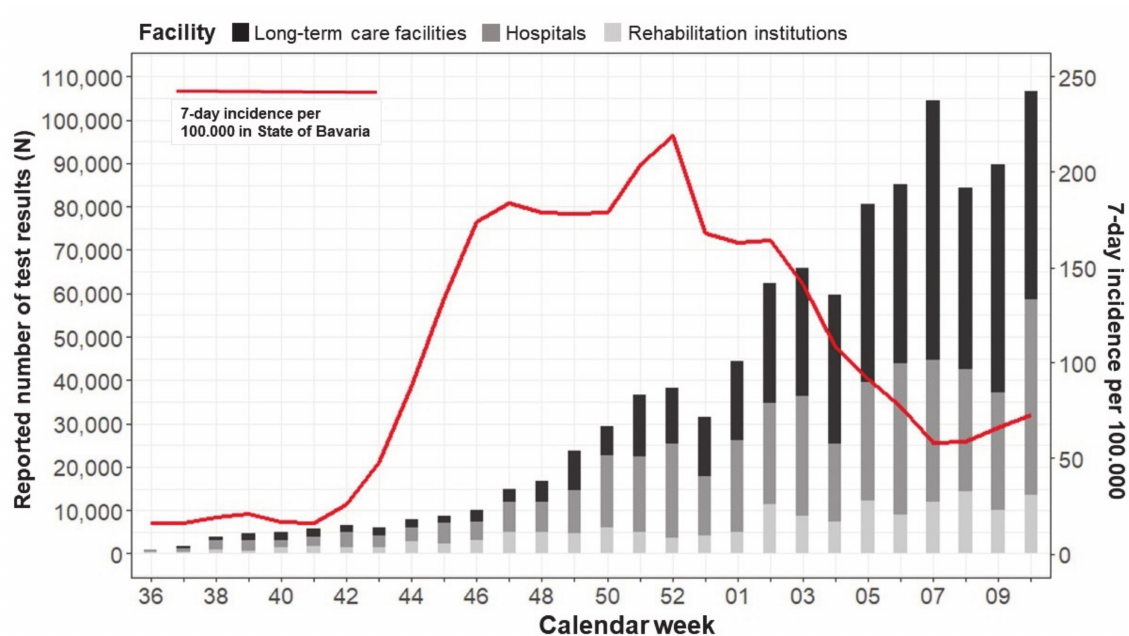
Figure 5. From September 2020 to March 2021, the combined weekly number of reported PCR and antigen tests for asymptomatic staff, patients/residents, and visitors of healthcare institutions are presented (bars). These tests were conducted as part of the voluntary SARS-CoV-2 screening program for hospitals, rehabilitation institutions, and care facilities for seniors and handicapped persons of the state of Bavaria, Germany. For the same period, the 7-day incidence per 100,000 inhabitants in Bavaria is presented (red